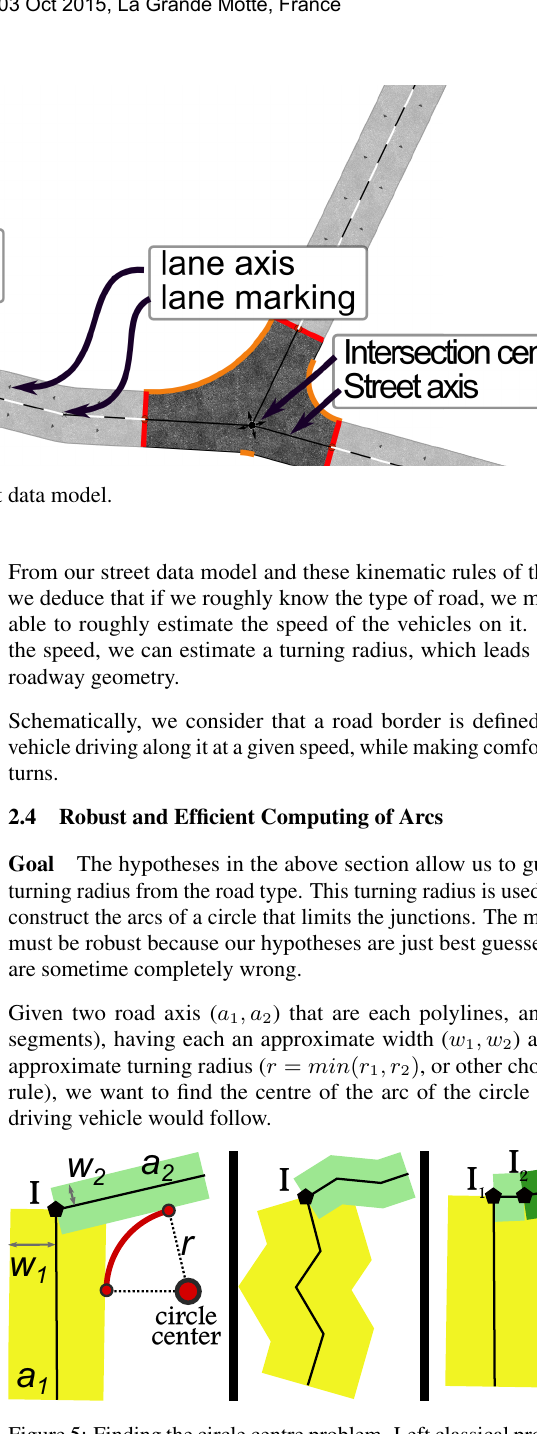
Figure 5: Finding the circle centre problem. Left classical problem, middle and right using real-world